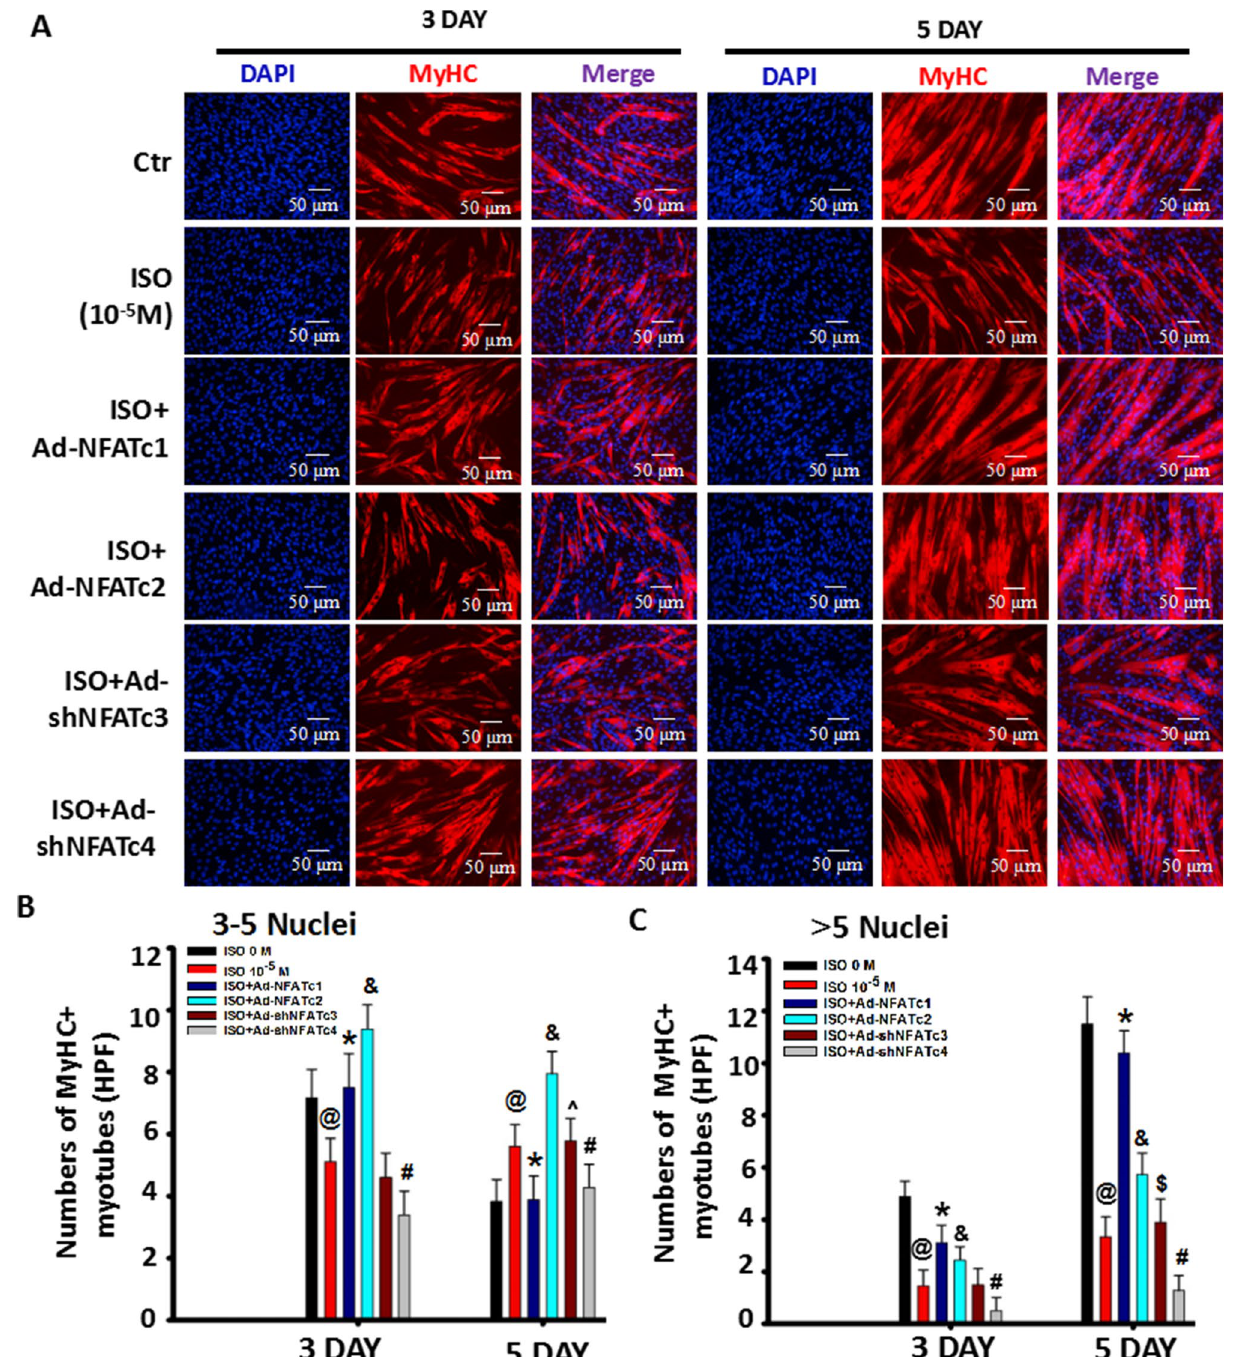
Figure 6. NFAT signaling is involved in the regulation of myotube size mediated by ISO. (A) Myoblast cells were stimulated with continuous single-dose ISO in differentiation medium for three and five days and stained with MyHC 24 h after transfection with adenovirus-mediated overexpression of NFATc1 (Ad-NFATc1) and NFATc2 (Ad-NFATc2) or knockdown of NFATc3 (Ad-shNFATc3) and NFATc4 by shRNA (Ad-shNFATc4) at 100 MOI. Three independently repeated experiments were performed. Then, a quantitative assay for the number of MyHC + cells with 1–2 nuclei was performed, as shown in ( A ). n = 3, @ P < 0.05 versus Ctrl; & P < 0.05 versus 0 M ISO, 10 −5 M ISO, ISO + Ad-NFATc1, ISO + Ad-NFATc12 or ISO + AdshNFATc4 group; # P < 0.05 versus all groups; *P < 0.05 versus all groups. ( B ) Quantitative assay for the number of MyHC + myotubes with 3–5 nuclei from Fig. 6. n = 3, @ P < 0.05 versus Ctrl; *P < 0.05 versus ISO group; & P < 0.05 versus 0 M ISO, 10 −5 M ISO or ISO + Ad-NFATc1 group; # P < 0.05 versus ISO group or ISO + AdshNFATc3 group; ^ P > 0.05 versus ISO group. ( C ) Quantitative assay for the number of MyHC + myotubes with more than 5 nuclei from ( A ). n = 3, @ P < 0.05 versus Ctrl; *P < 0.05 versus ISO group; & P < 0.05 versus 0 M ISO, 10 −5 M ISO or ISO + Ad-NFATc1 group; # P < 0.05 versus ISO group or ISO + AdshNFATc3 group; $ P > 0.05 versus ISO group. Three independently repeated experiments were